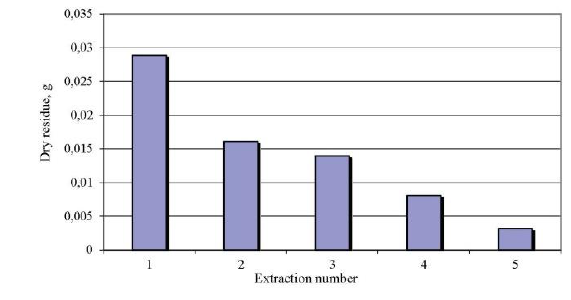
Fig. 7. Determination of the optimal extraction multiplic- ity based on the dry residue